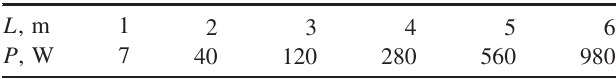
TABLE VI. Heat load on last wiggler beam pipe after a horizontal absorber for different wiggler lengths L .